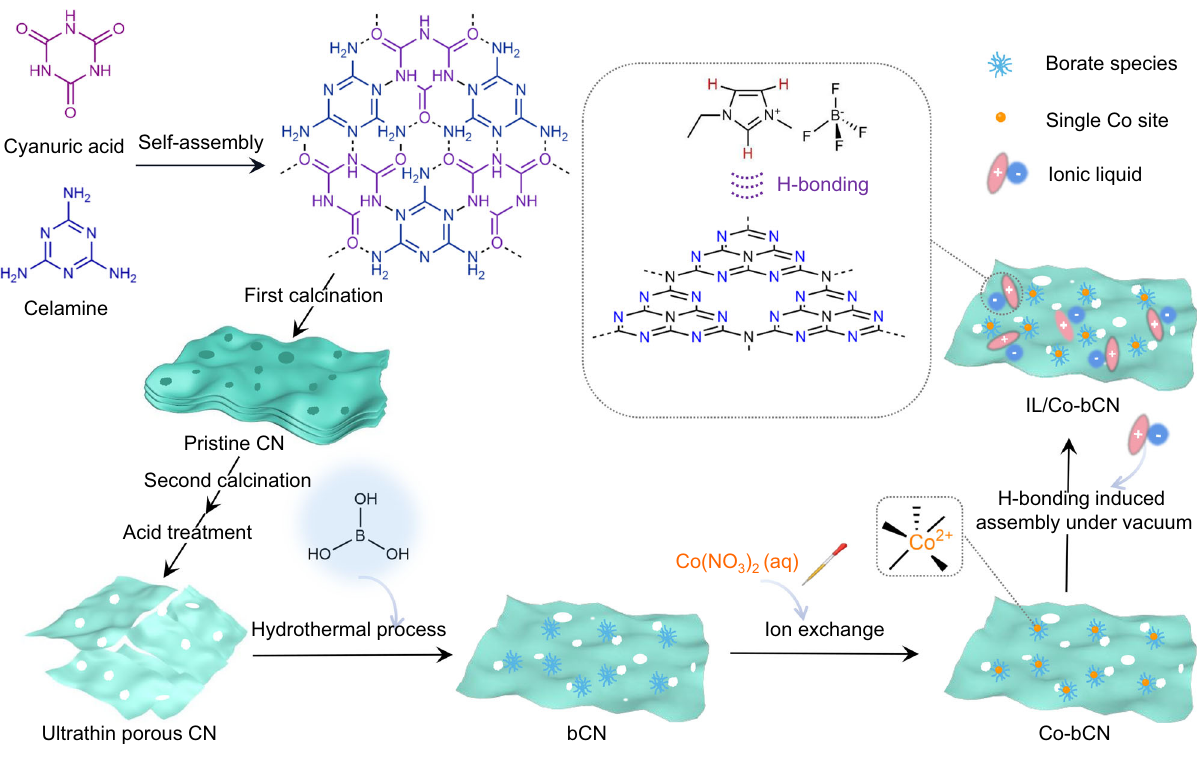
Fig.1|IllustrationofthesyntheticproceduresofIL/Co-bCNphotocatalysts. IL: ionic liquid 1-ethyl-3-methylimidazolium tetra fl uoroborate ([emim][BF 4 ]) is pre- sentedbypinkovalcationandbluecircleanion;bCN:boricacidmodi fi edultrathin